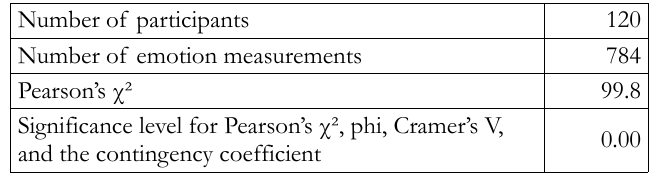
Table 2. Test statistics and significance